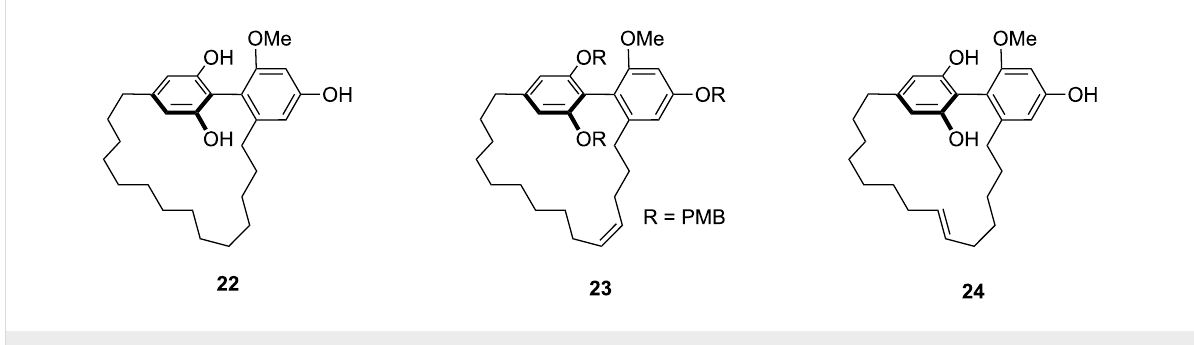
Figure 5: Turriane family of natural products.